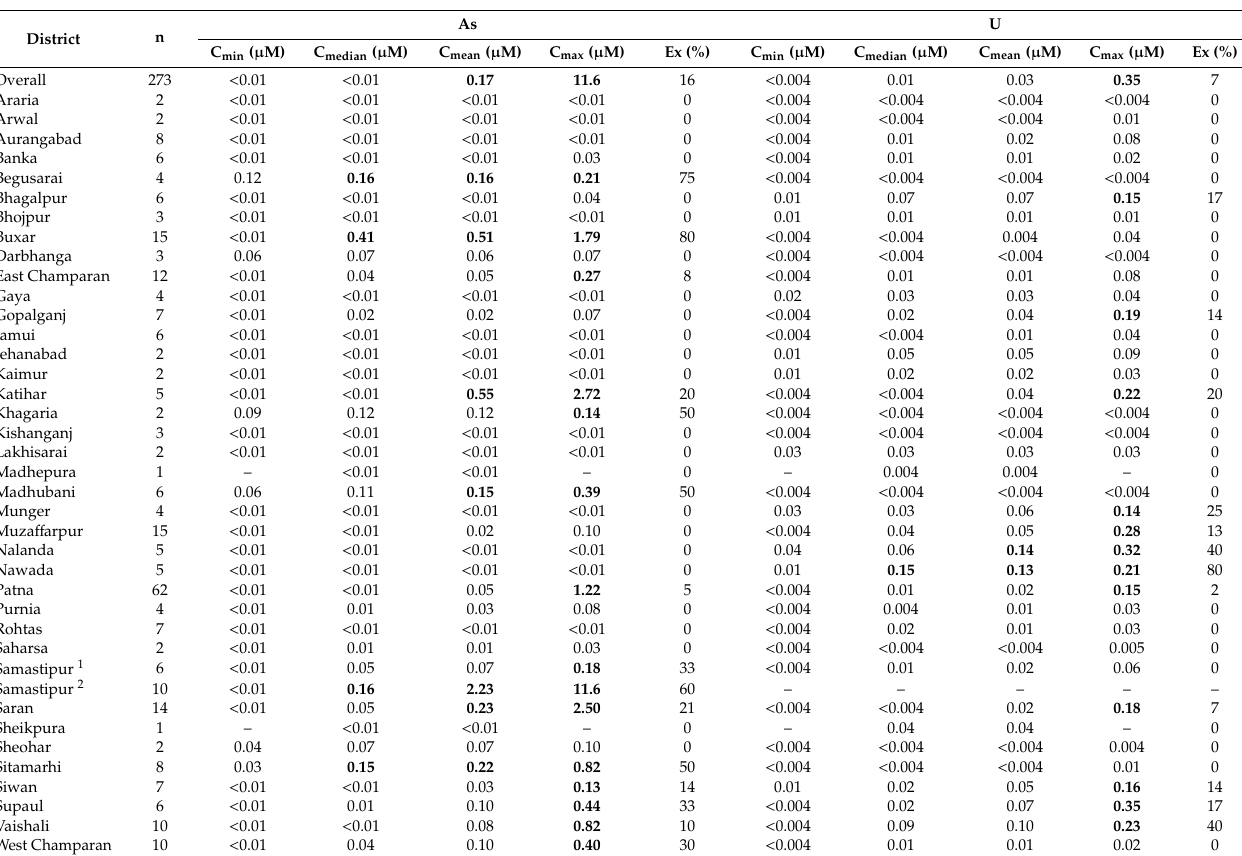
Table 2. Summary statistics for geochemistry of Bihar groundwater. District-level and overall summary statistics for As and U show minimum, median, mean and maximum concentrations (C min , C median , C mean , C max , respectively) and percentage of samples exceeding WHO provisional guideline values (Ex). WHO provisional guidelines [4] are 0.13 µ M (10 µ g.L − 1 ) for As and 0.13 µ M (30 µ g.L − 1 ) for U. Bold / underlined font indicate where C median , C mean or C max exceeds WHO guidelines. Samples with measured concentrations below detection for a particular analyte are included as zero in summary statistic